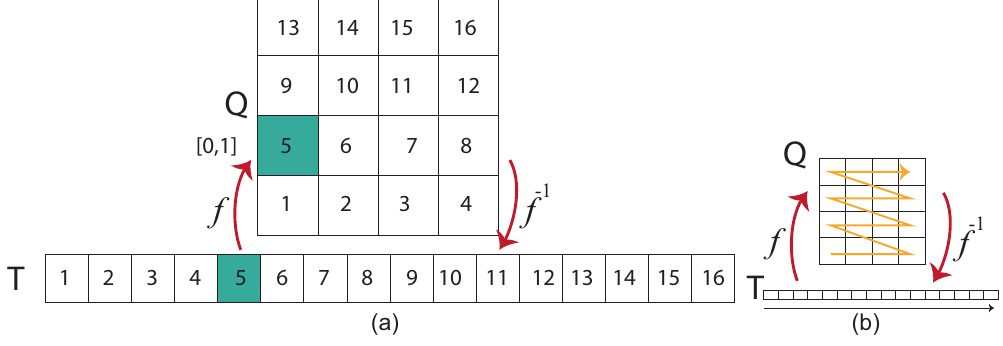
Figure 7. ( a ) Function f maps parameters on T to domain Q . For instance, t = 5 is mapped to [0 , 1] . Parameters on T are used as indices of Q . ( b ) A space filling curve that performs row major traversal is illustrated in orange.